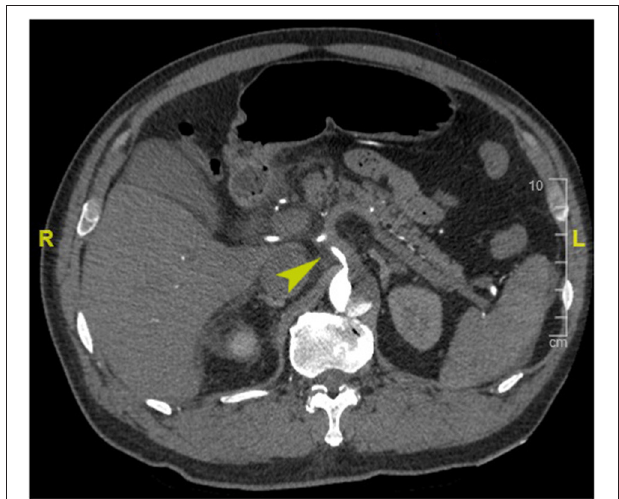
FIGURE 1 | Enhanced computed tomography angiography image of a representative case of preoperative celiac trunk malperfusion